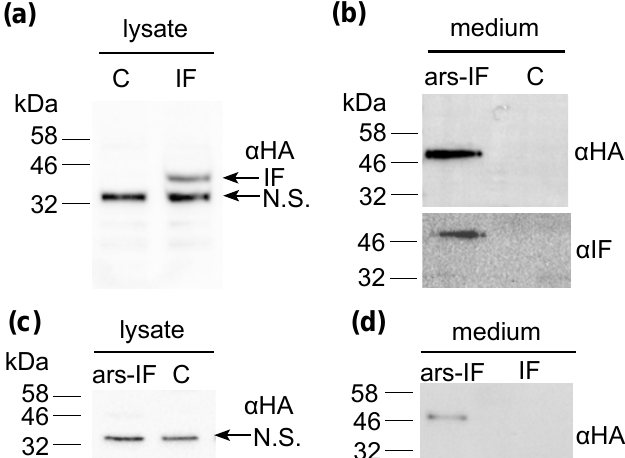
Figure 2. Expression of human intrinsic factor (IF) protein and ars ‐ IF in C. reinhardtii CC ‐ 849 detected by immunoblot analysis using HA ( α HA) and intrinsic factor ( α IF) antibodies, respectively, in the culture medium and cellular lysates. ( a ) Cellular lysates of IF strain expressing the protein. The protein band is indicated with an arrow (IF). A second, non ‐ specific band cross ‐ reacting with the HA antiserum is indicated (N.S.). ( b ) Culture supernatant (medium) of transformed CC ‐ 849 strain expressing ars ‐ IF. ‘C’ indicates a negative control (cellular lysate and supernatant of the untransformed CC ‐ 849 strain). ( c ) Cellular lysates of ars ‐ IF strain and CC ‐ 849. ( d ) Culture medium of ars ‐ IF and IF strain.